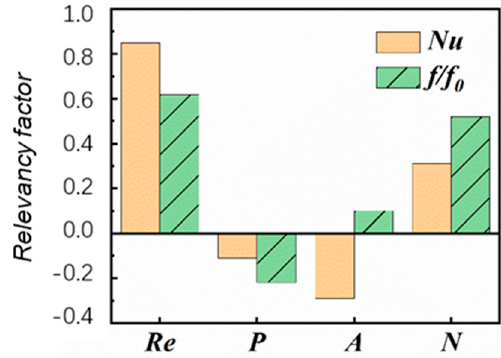
Figure 15. Coefficient Plots for 𝑁𝑢 and 𝑓/𝑓 (cid:2868) .